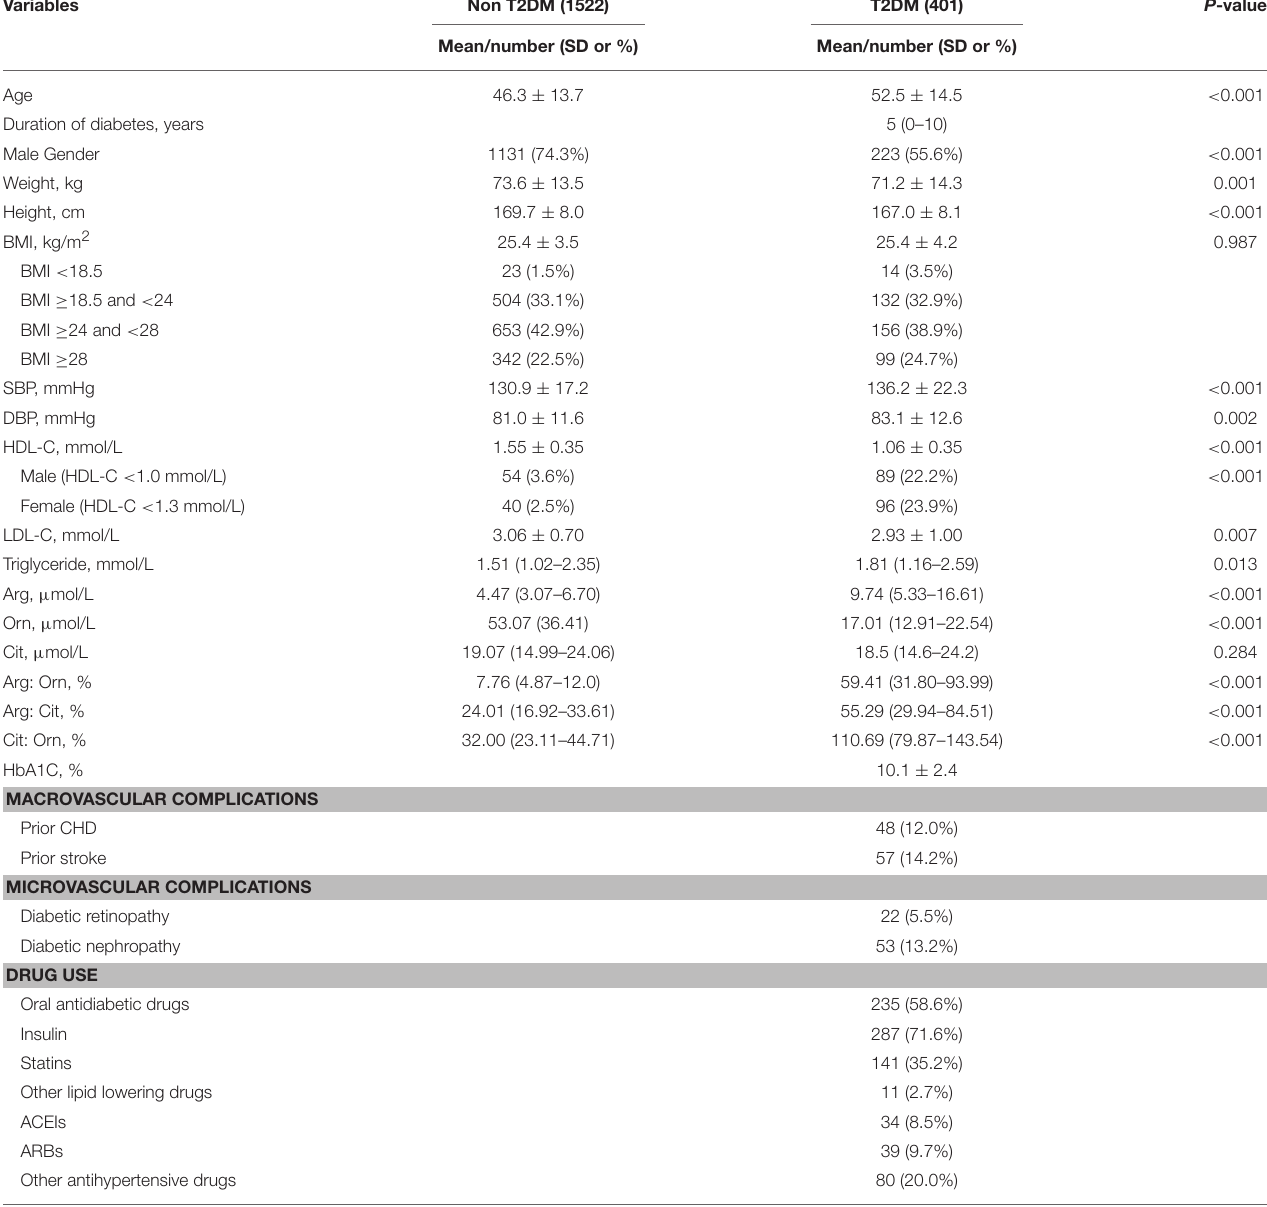
TABLE 1 | Clinical and biochemical characteristics of subjects according to occurrence of type 2 diabetes mellitus (T2DM).